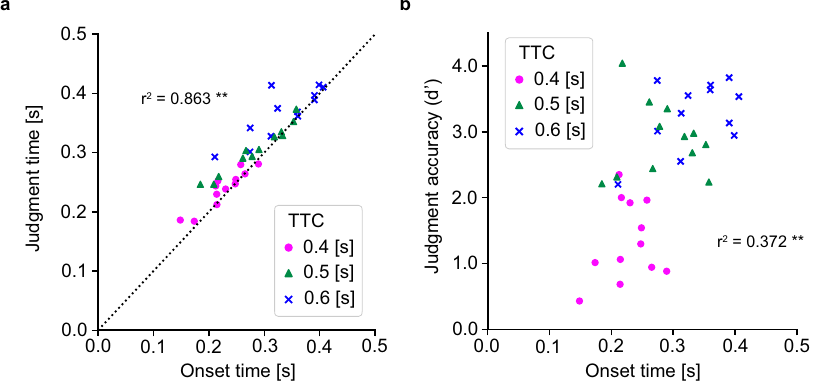
Fig. 3 TTC-dependent relationship between judgment and movement features. a , b Relations between the mean movement onset time and the judgement time ( a ) and the judgement accuracy (d ′ ) ( b ) for each TTC (0.4 s: magenta circle, 0.5 s: green triangle, and 0.6 s: blue cross). r 2 represents the coef fi cient of determination. ( n = 12, ** p < 0.01). Please note that the movement onset time was strongly correlated with judgment time and judgement